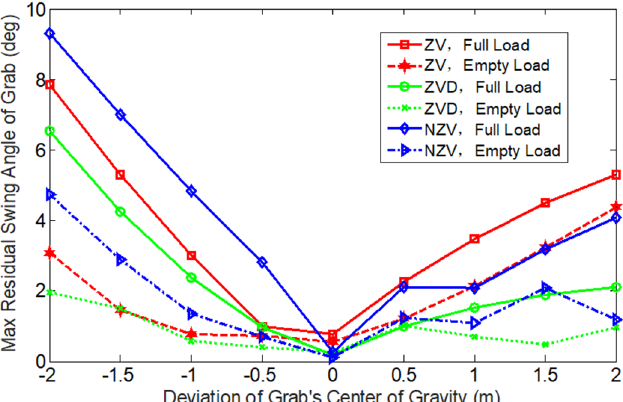
Fig. 9. Maximum residual swing angle curves with the deviation of the grab ’ s center of gravity along the